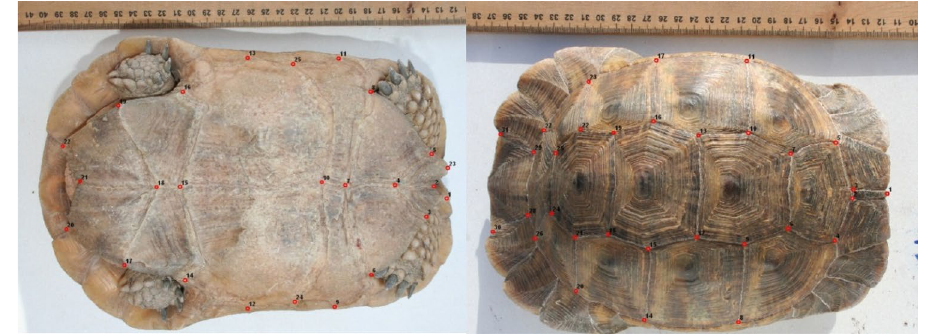
Figure 11. The defined landmarks for extracting the shape data of T. graeca in Central